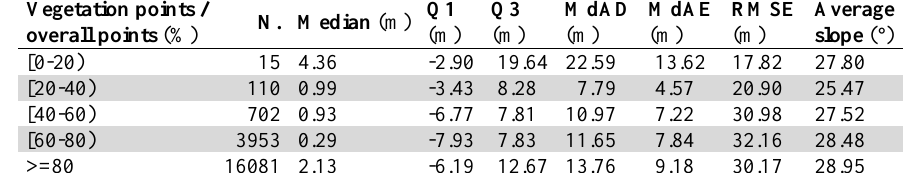
Vegetation points /